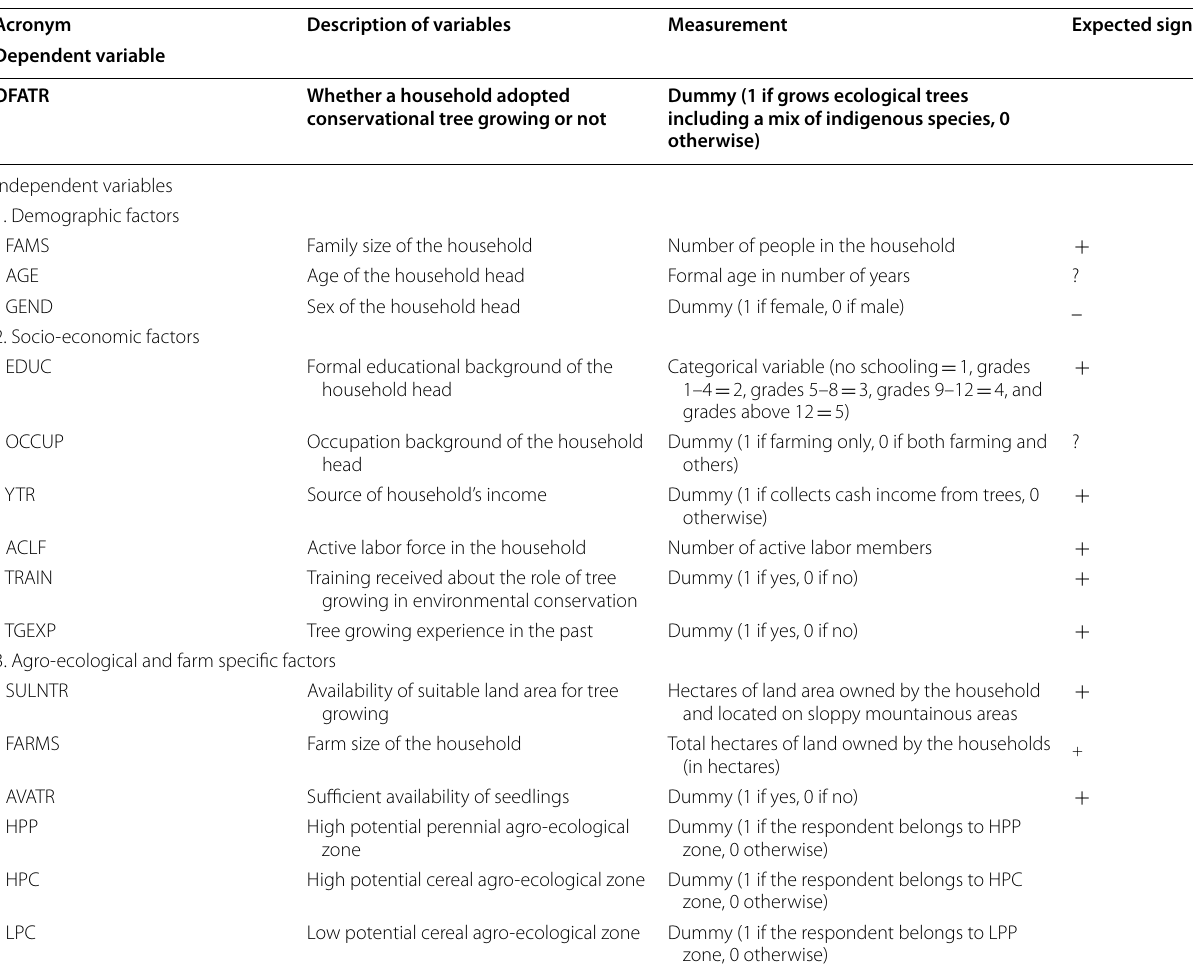
Table 1 Determinants of OFATR with expected hypothesized